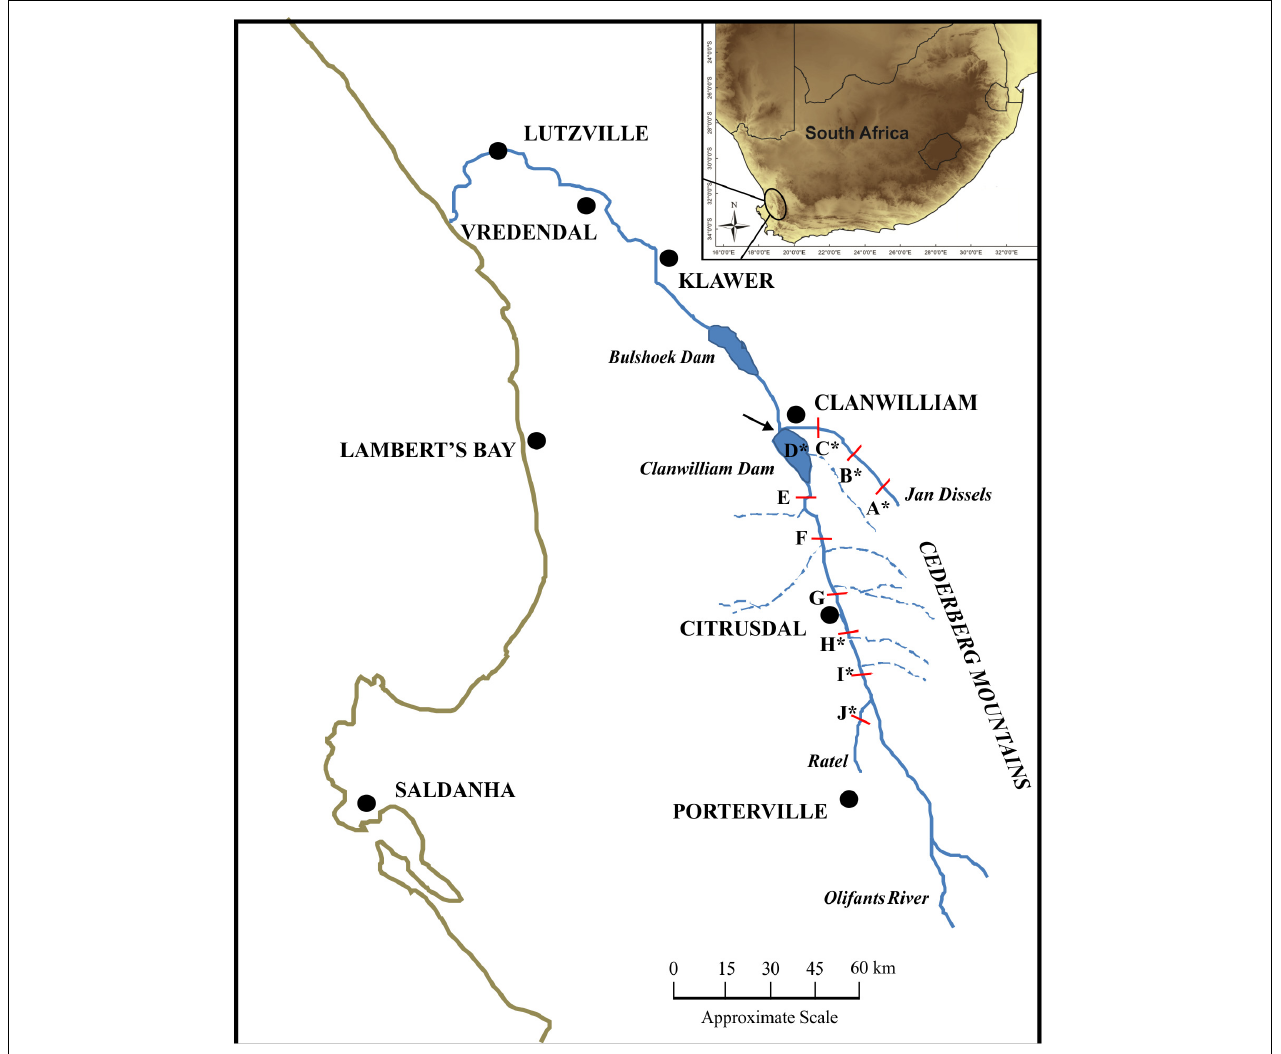
FIGURE 1 | The sampling localities within the Olifants River system of the Western Cape, South Africa. All letters (A – J) represent sampled localities used for the linear and geometric morphometric measures, while localities sampled for the genetic analyses are indicated with an asterisk (*). Localities A – C represent those sampled in the Jan Dissels River tributary, while locality D represents the Clanwilliam Dam. Localities E – I represent sampled localities situated within the mainstem of the Olifants River and locality J represents the Ratel River tributary. The Clanwilliam Dam sluice gates are indicated with an